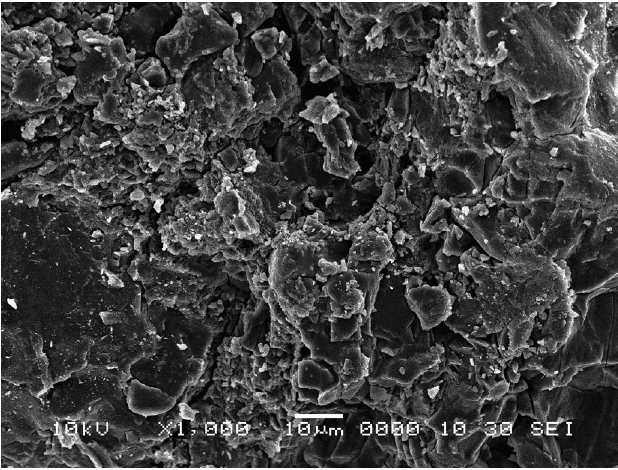
FIGURE 5 - Scanning electron microscopy of non pareil seeds (X1000).